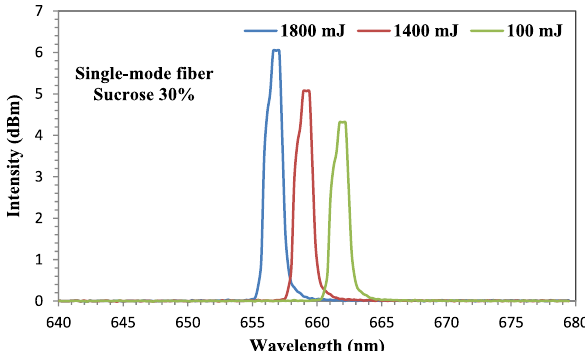
Figure 14. The output spectra of the fiber-optic immersed in Sucrose solution at ablated energies of 1000, 1400, and 1800 mJ.